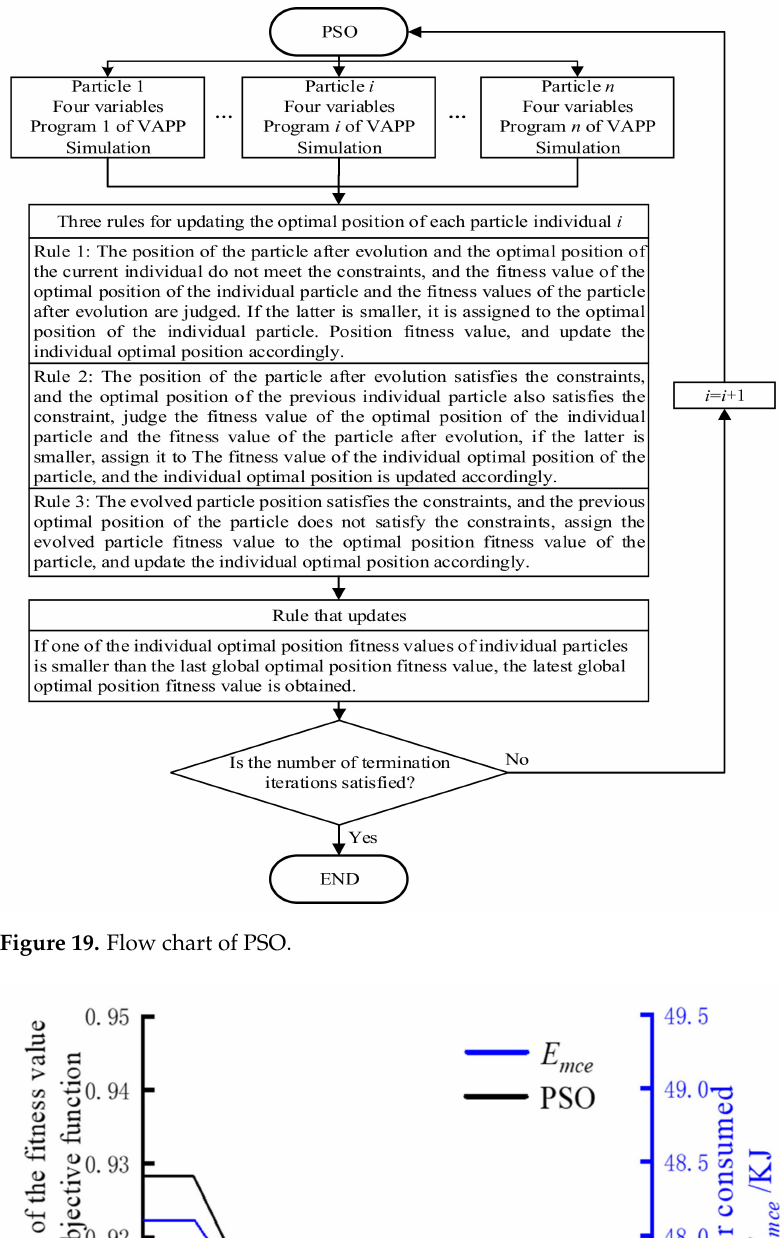
Figure 19. Flow chart of PSO.